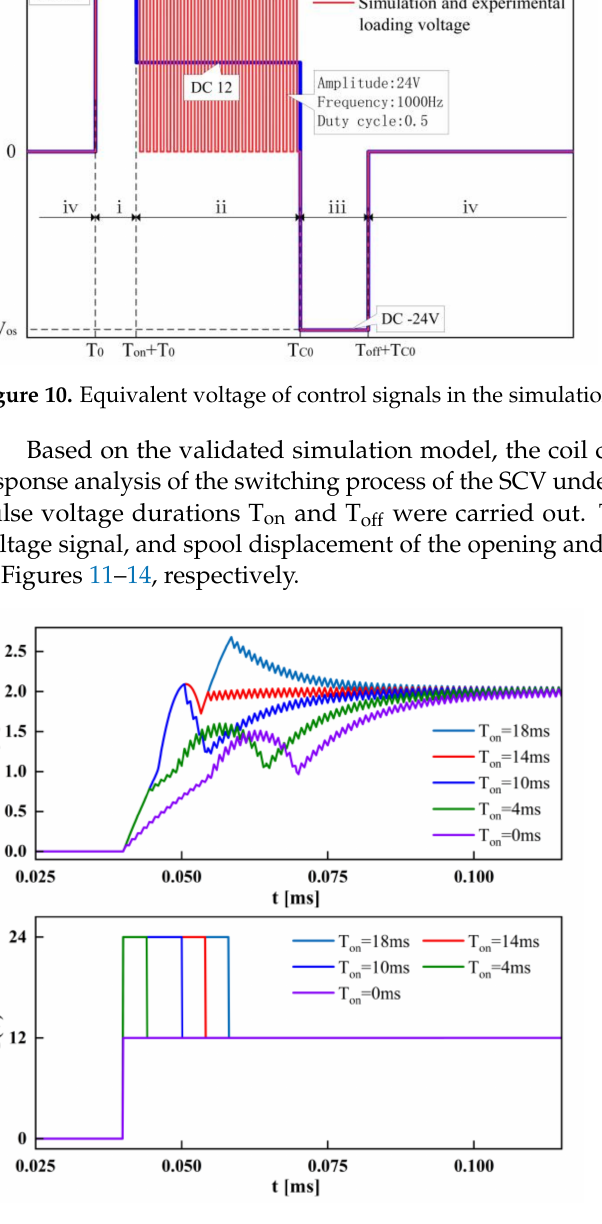
Figure 11. Simulated dynamic responses of the coil current under different switching times (T on ) in the opening